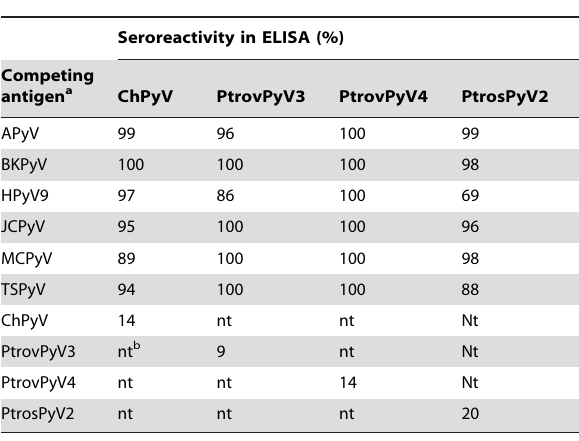
Table 5. Competitive inhibition of seroreactivity between human and chimpanzee polyomaviruses.